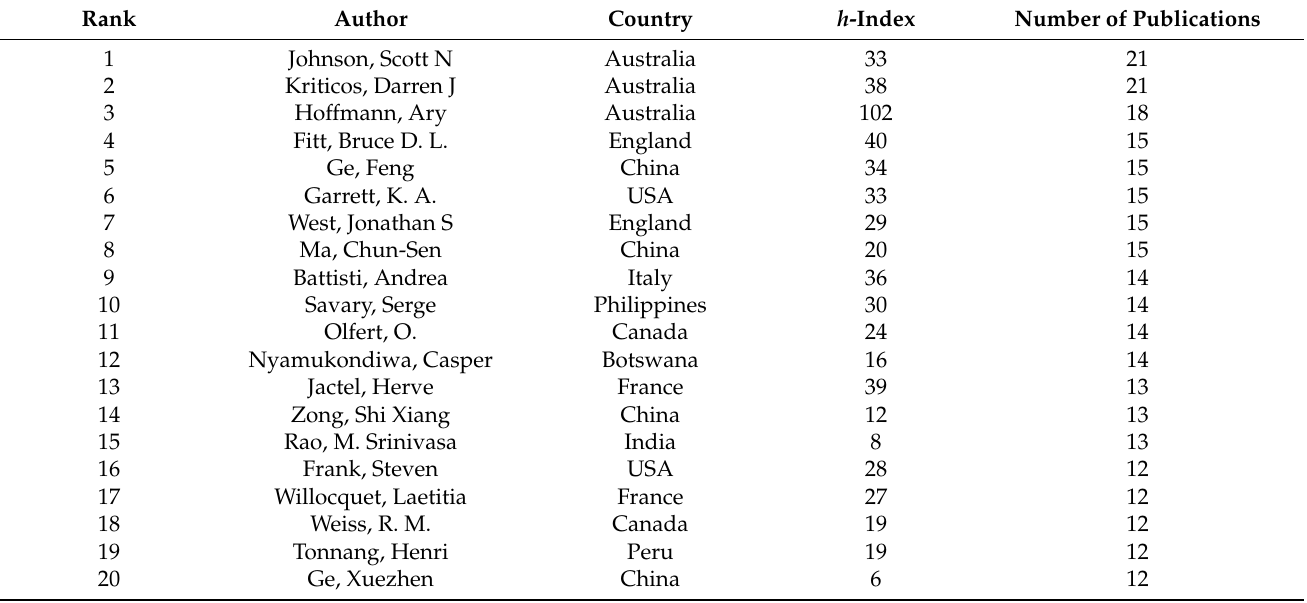
Figure 3. Knowledge mapping of cooperation between countries/regions the impact of climate change on crop pests and diseases. Table 3. Information on the top 20 authors in terms of number of articles